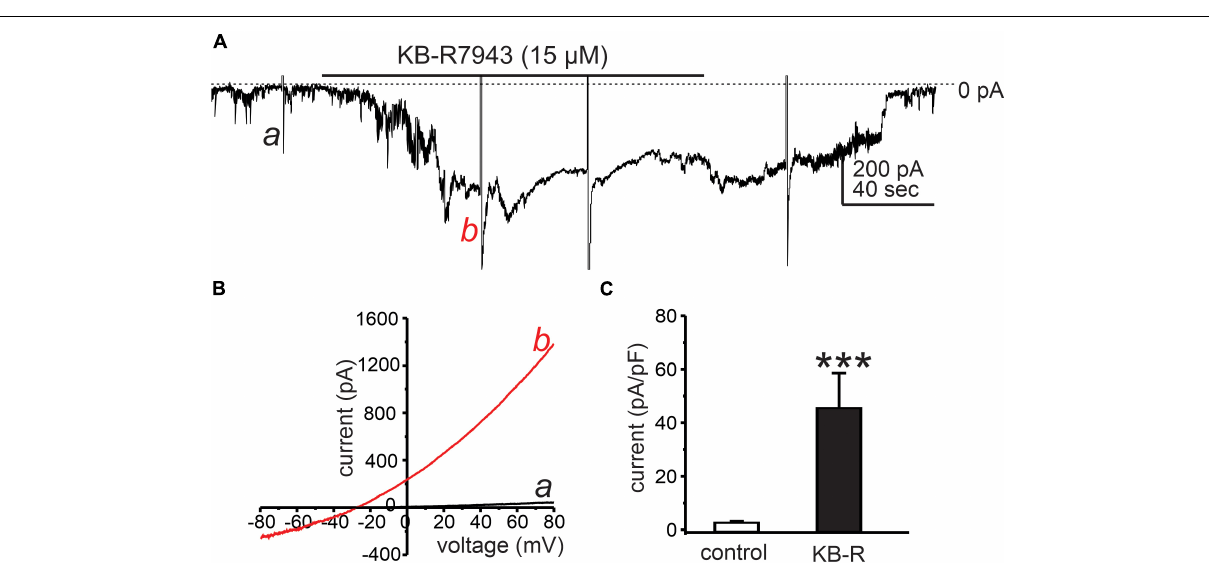
tail currents (from − 636 ± 148 to − 1466 ± 396 pA, p < 0.05)